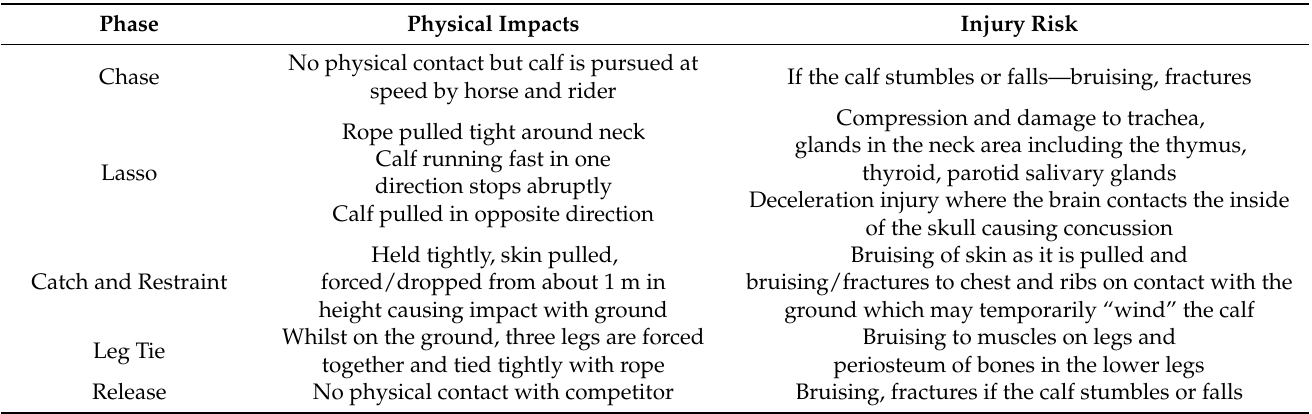
Table 2. The physical impacts and risks of injury to calves for each of the phases of calf roping. Phase Injury